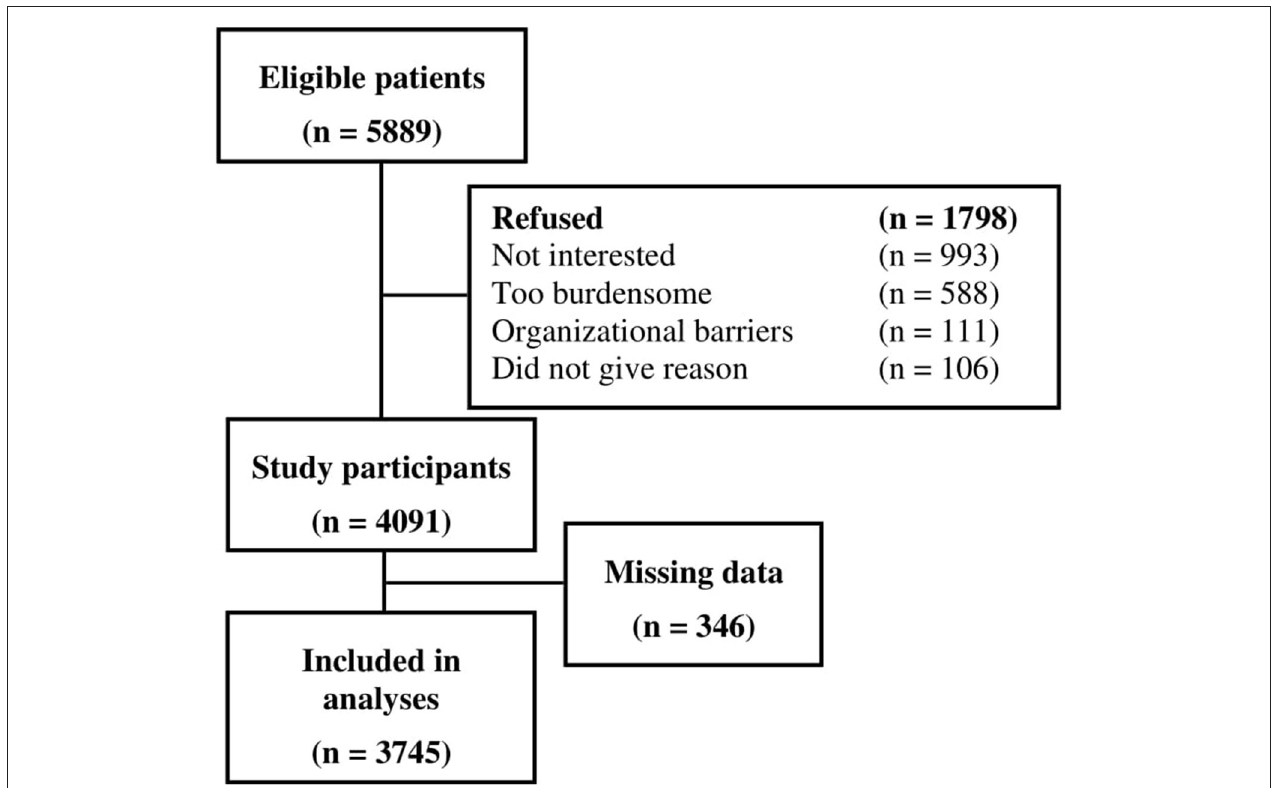
FIGURE 1 | Participant flow including reasons for non-participation.